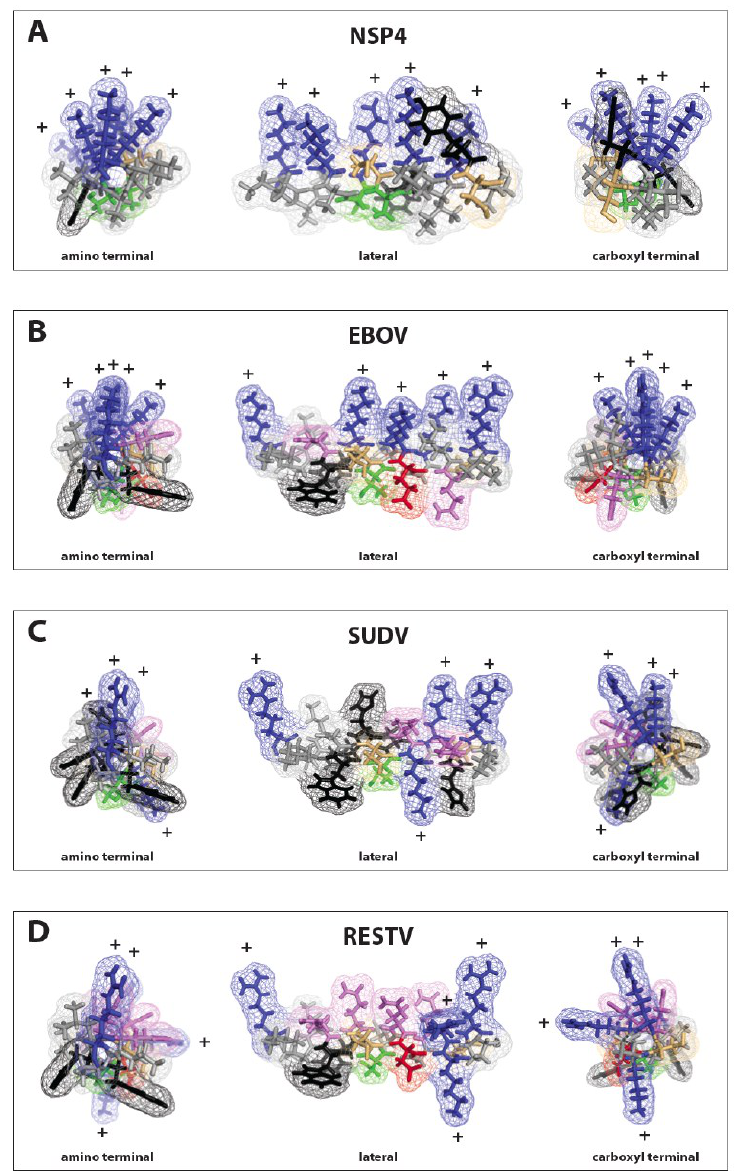
Figure 2. Modeling of the lysin motifs of NSP4 and filovirus delta peptides. The PyMol graphics program [36] was used to model the viroporins NSP4 of rotavirus and the lysin motifs in the carboxy-terminal regions of delta peptides from three different ebolavirus species, EBOV, SUDV and the RESTV as alpha helices. ( A ) rotavirus NSP4; ( B ) EBOV delta peptide; ( C ) SUDV delta peptide; ( D ) RESTV delta peptide. To the left is a